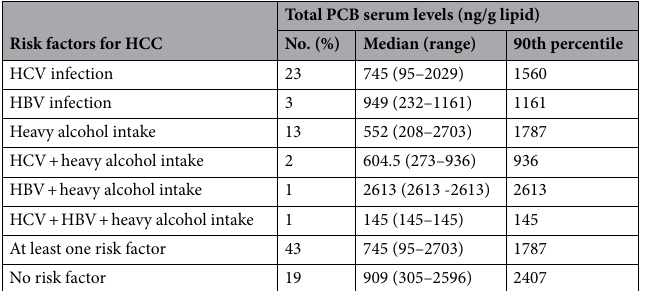
Risk factors for